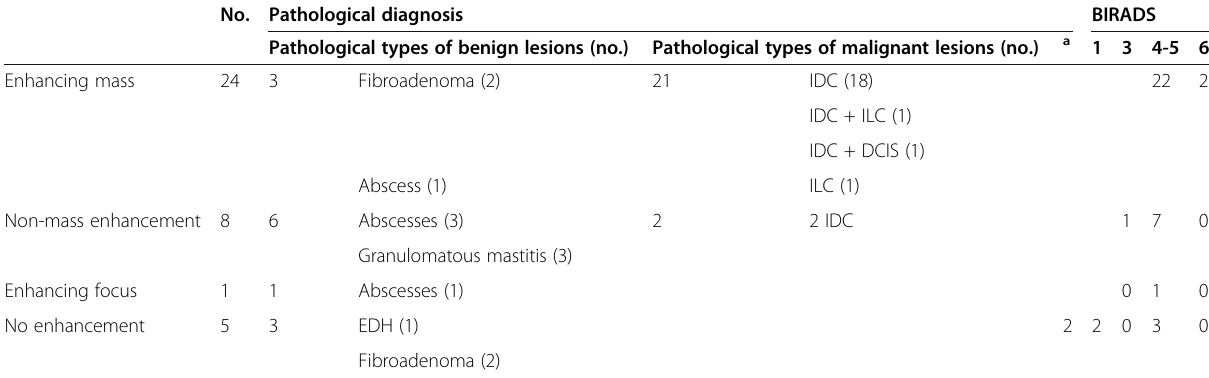
Table 1 Data representing CEDM, pathological, and sonomammographic (BIRADS)